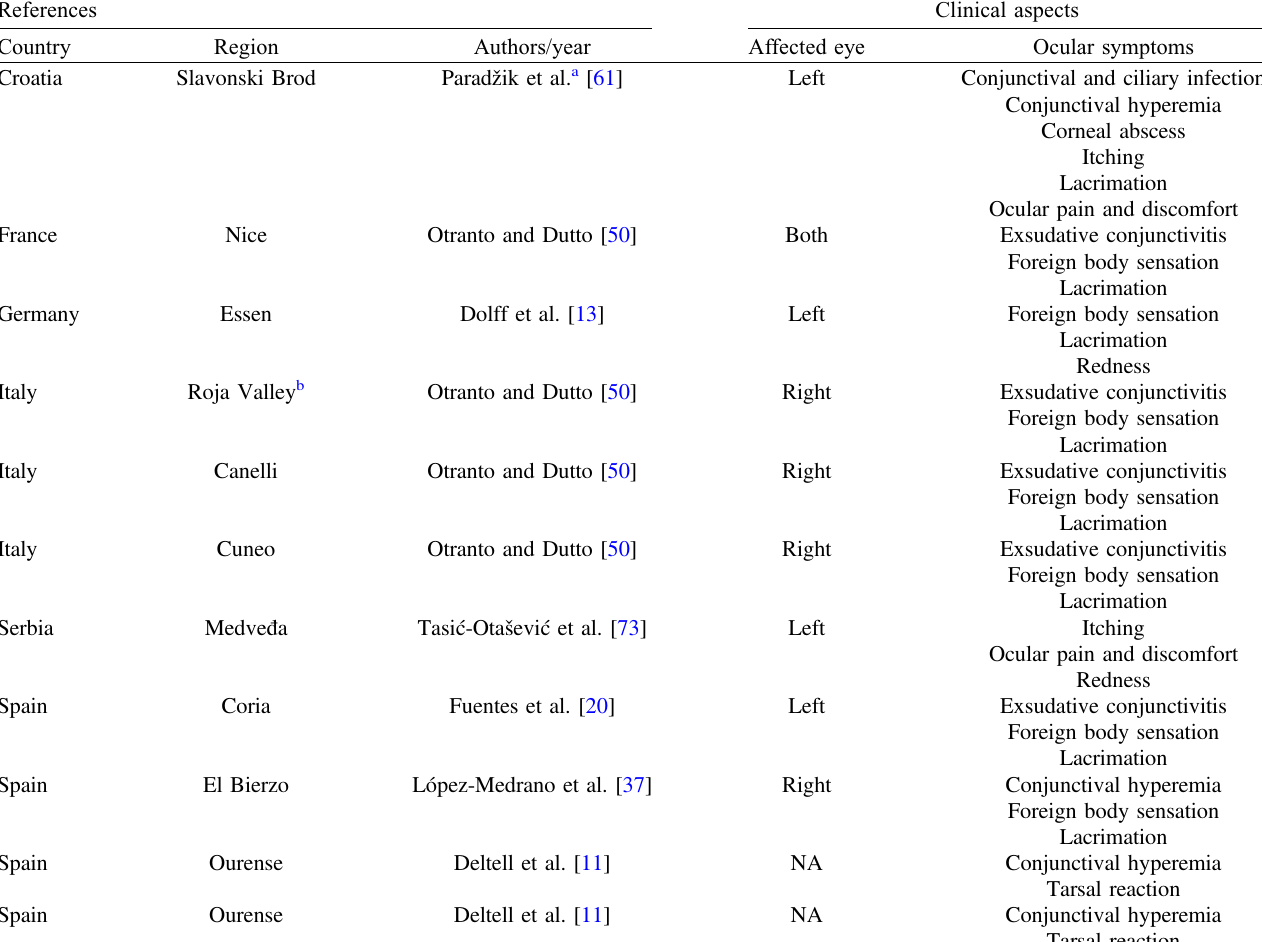
Table 3. Features of the studies included in the qualitative analysis regarding T . callipaeda infection in